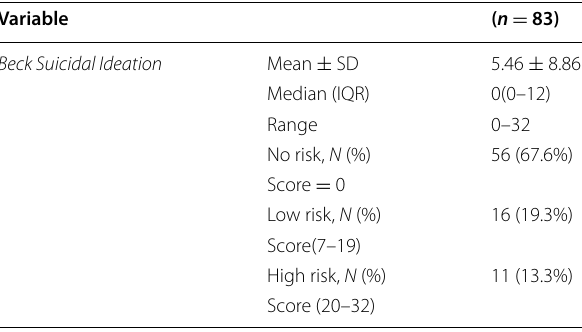
Table 4 Suicidal ideation among the studied